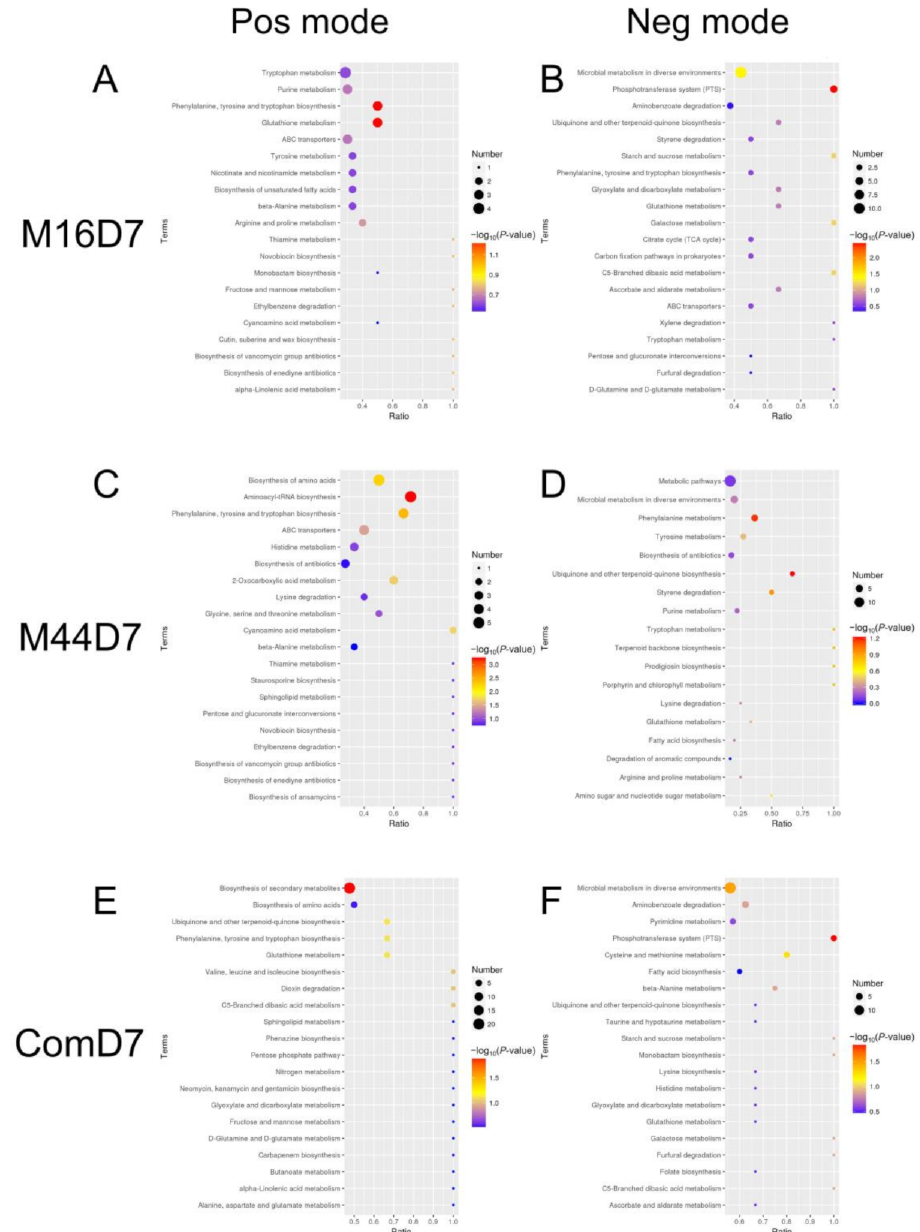
Figure 3. Bubble diagram of KEGG pathway enrichment analysis. ( A ) M16D7 in positive mode. ( B ) M16D7 in negative mode. ( C ) M44D7 in positive mode. ( D ) M44D7 in negative mode. ( E ) ComD7 in positive mode. ( F ) ComD7 in negative mode. CK: control; M16: M16 treatment; M44: M44 treatment; Com: combination of M16 and M44; D7: day